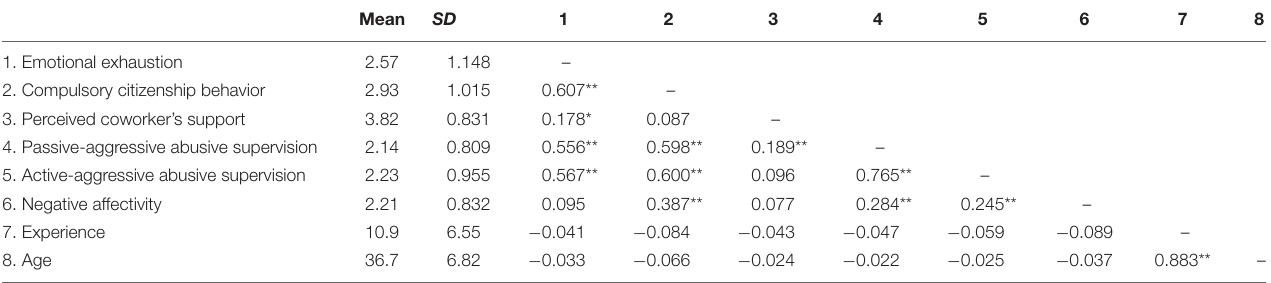
TABLE 1 | Summary statistics and correlation of variables